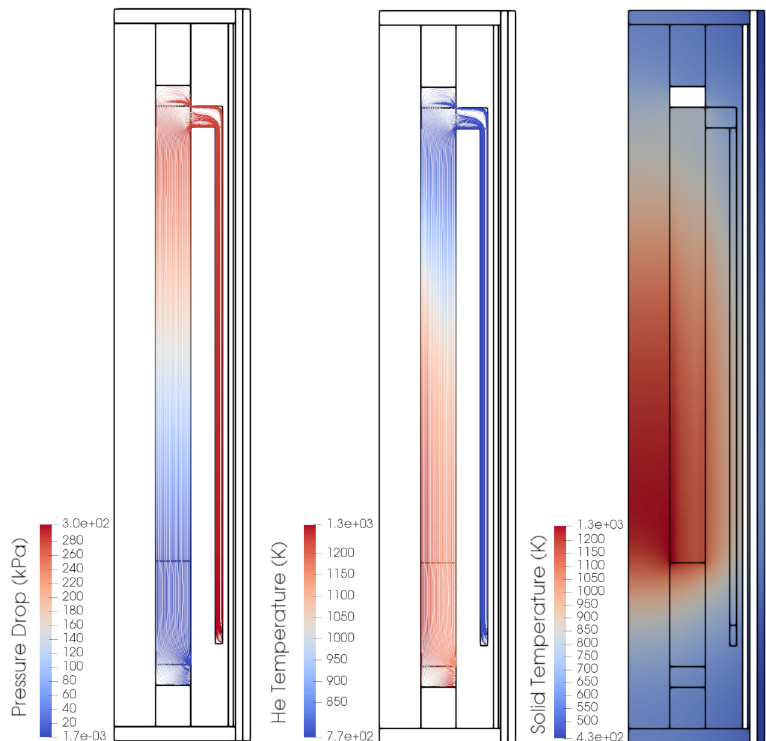
Figure 10: 2D Results - Pressure Drop, He Temperature, Solid Structures Temperature The steady-state helium pressure, temperature and velocity streamlines are shown in Fig. 10 (left- center). The helium temperature increases once it enters into the pebble bed where the power is generated. The spatial temperature distribution shows a temperature peak of 1 , 300 K close to the bottom center of the core. This value is not visible in the axial and radial profiles because they show radial and axial averages of the temperature, respectively, and only a small volume reaches temperatures close to the peak temperature. The streamlines show how most of the helium flows directly into the bed and just a small amount flows into the top cavity. Helium originating from dif- ferent radial positions in the core mixes in the outlet plenum to produce the average helium outlet temperature. In Fig. 10 (right) the pebble surface temperature and the graphite structures temper- ature are shown. In normal operation, most of the heat generated in the pebble bed is removed by the helium flow but the central reflector graphite has no active cooling (this is a benchmark sim- plification in reality active cooling is provided); therefore its temperature is at least 500 K higher than the rest of the graphite in the